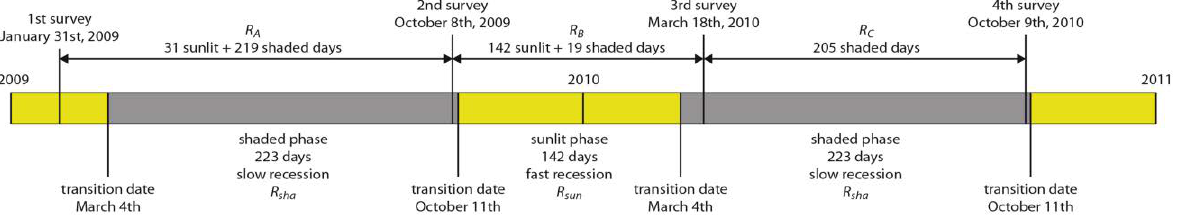
Figure 2: Sequence of sunlit and shaded phases as well as of survey dates at the sample cliff. The given amounts of days are approximate values and underlie small interannual variations. See text for